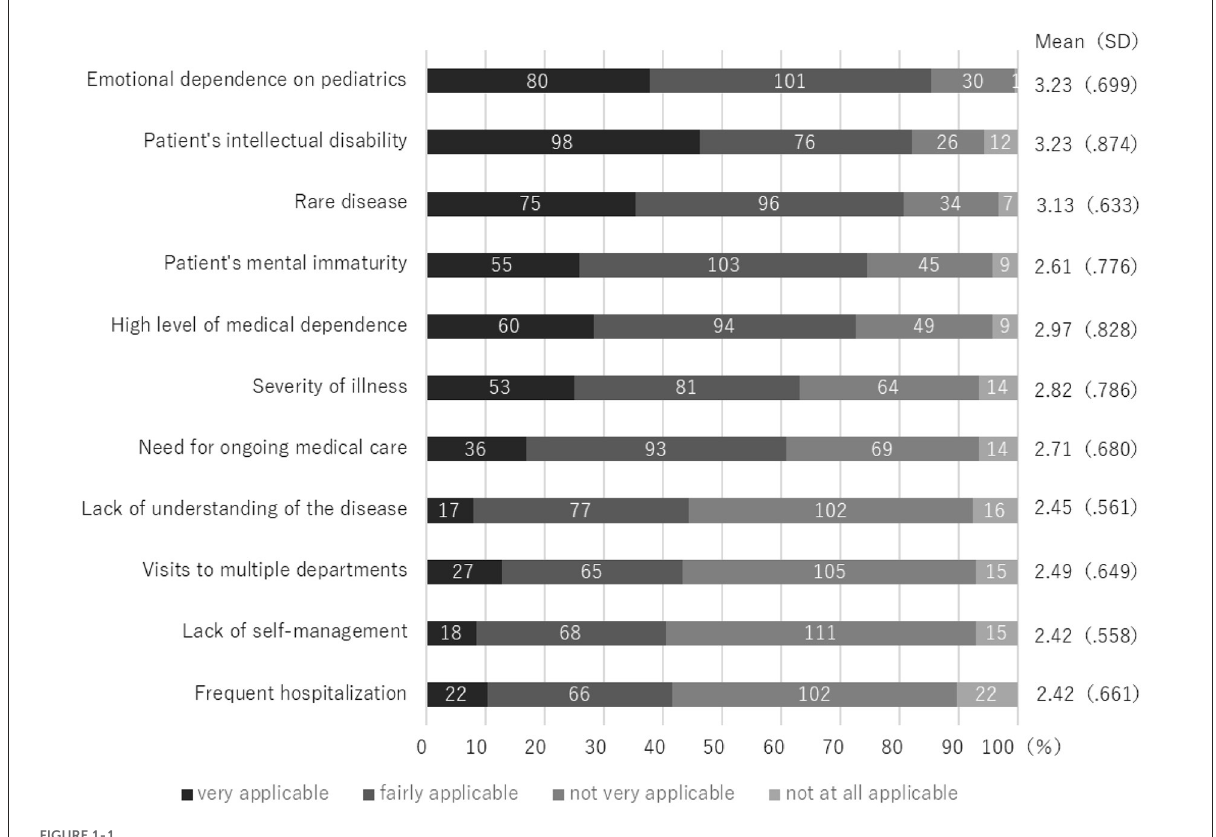
FIGURE1-1 Barrier to Transition from Pediatric to Adult care: Patient Factors ( n =